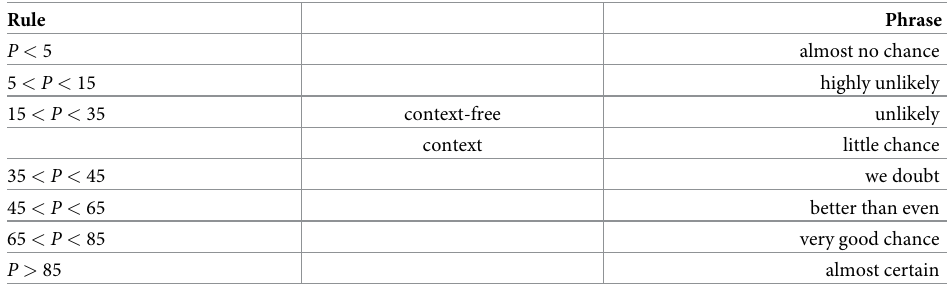
Table 3. The decision rule for predicting phrase from percentage (P) with the “uncertainty” prompt. The phrases and their numbers are as listed in the Process section. Rule Phrase P < 5 almost no chance 5 < P < 15 highly unlikely 15 < P < 35 context-free unlikely context little chance 35 < P < 45 we doubt 45 < P < 65 better than even 65 < P < 85 very good chance P > 85 almost